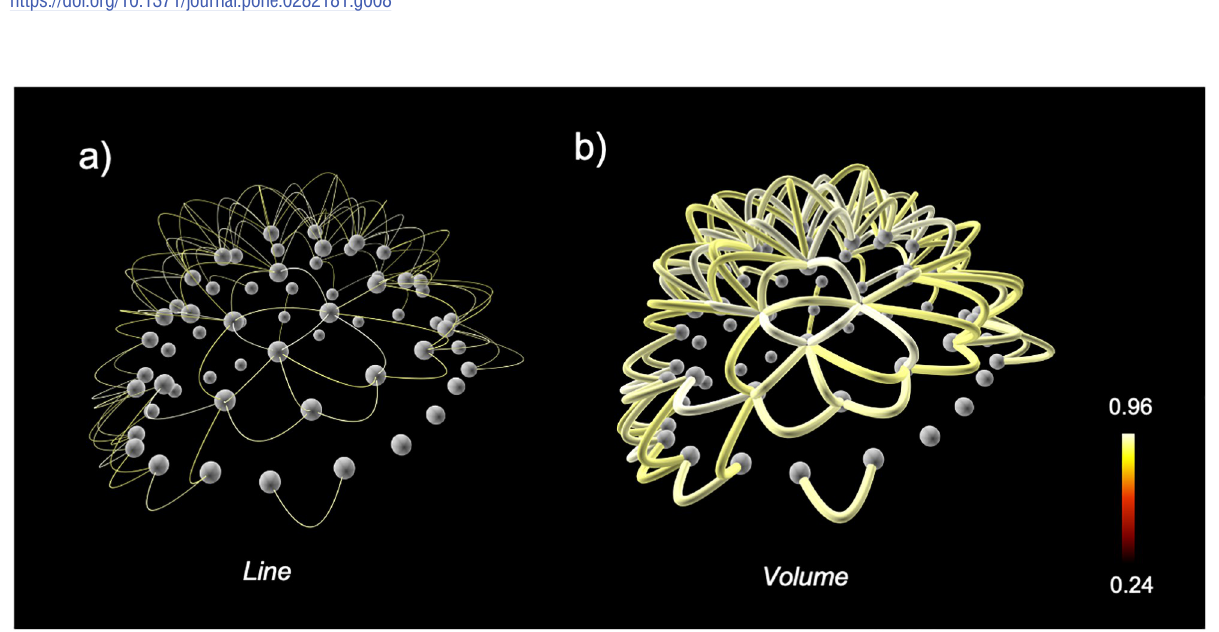
Fig 9. Graphical implementation of the links. a) Line option: links are made of single pixels. b) Volume option: links are made of multiple adjacent cylinders along the path between the two connected nodes. This synthetic network has been visualized with Vizaj using a Default shape for the links.